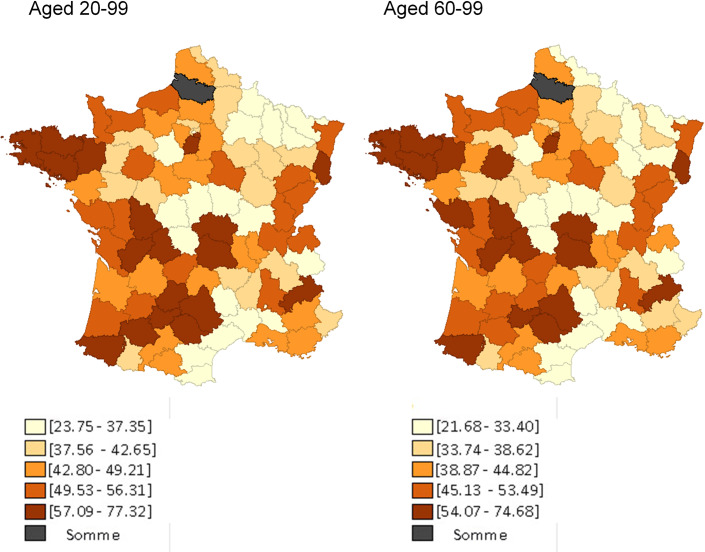
Département-level quintiles of rates of genetic testing for NSCLC in France among inhabitants aged 20–99 (left) and those aged 60–99 (right), April 2012 –April 2013.For each département, we know where unique patients living in that département were admitted for lung cancer. Using that information, we calculated the département-specific proportion of hospital stays (for males and females, separately) that were provided to patients who lived in that département and in any other département. For instance, during the study’s period, among males, there were 68 lung cancer admissions in Loir-et-Cher (department 41): 96% of those admissions were for patients who lived in Loir-et-Cher, but 2.5% were for patients who lived in Indre-et-Loire (department 36) and 1.5% were for patients who lived in Loiret (department 45). To estimate the number of genetic tests done on patients who lived in a particular département, we then allocated tests obtained in a département according to how patients had been admitted for lung cancer. Therefore, continuing our example, we allocated the 30 genetic tests that were ordered on males by physicians working in Loir-et-Cher accordingly: 28.78 (96%) to Loir-et-Cher, 0.77 (2.5%) to Indre-et-Loire, and 0.44 (1.5%) to Loiret. We then added all allocated tests expected to have been received by males and females, separately, who lived in each département. Data from the départements ‘Somme’ and ‘Corsica (North and South)’ are missing.